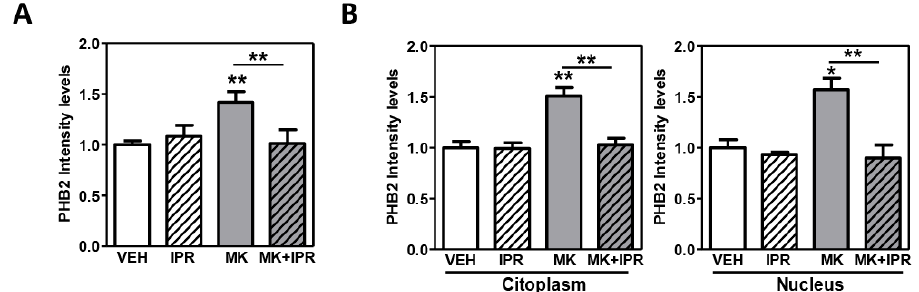
Figure 4. Immunocytochemistry of PHB2 in cortical neurons: ( A ) Each bar represents the mean and the standard error of the mean for each group for PHB2 protein intensity levels referred to the number of nuclei and the control group of three independent experiments. ( B ) Each bar represents the mean and the standard error of the mean for the nuclear and cytoplasm PHB2 protein intensities in all treatment conditions. Levels referred to the number of nuclei and the control group of three independent experiments. (* p < 0.05, ** p <